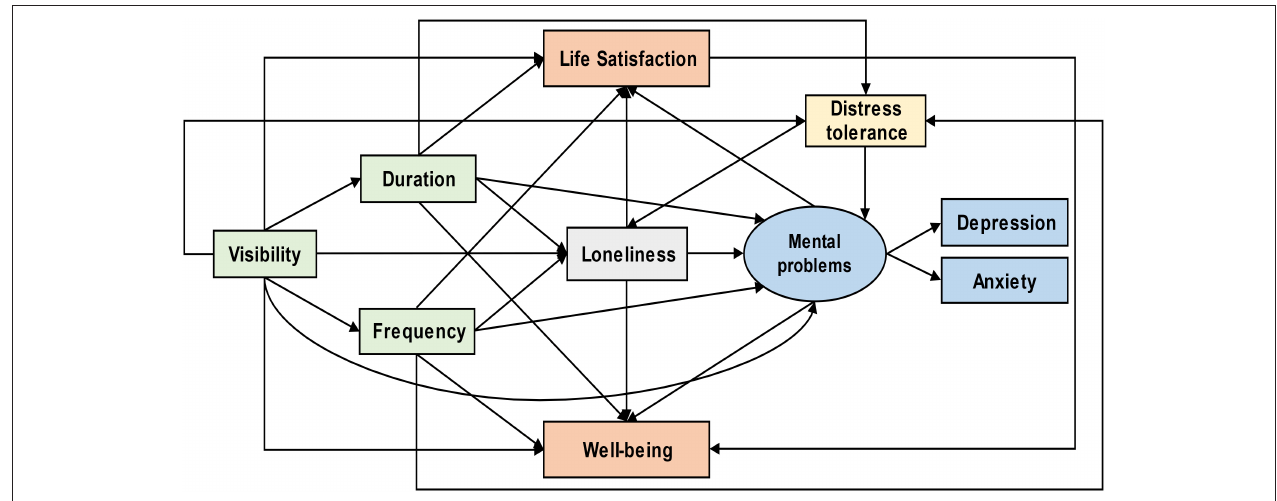
FIGURE 1 | Conceptual framework of nature exposure through window: Prisoners’ life satisfaction and well-being.